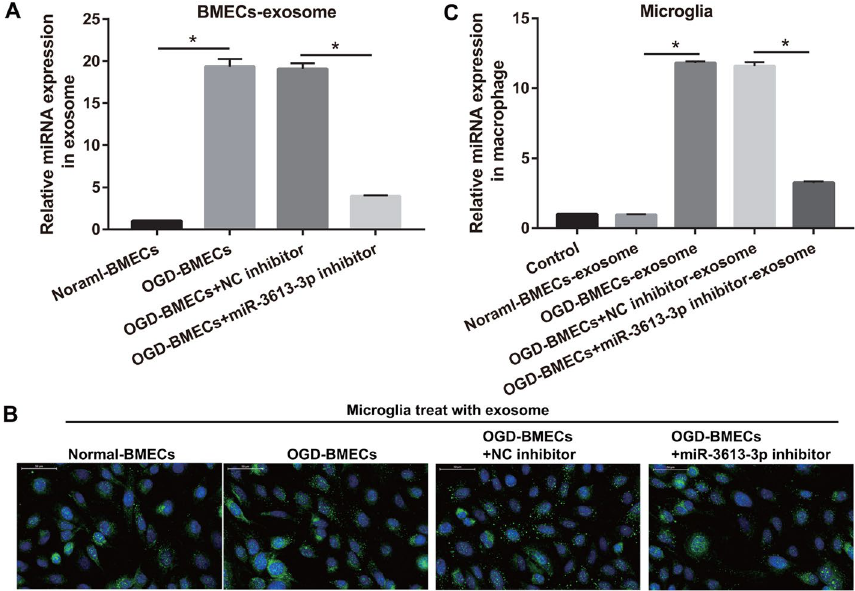
Fig. 2 BMECs secrete miR-3613-3p to transfer into microglia via exosomes. A miR-3613-3p expression in BMEC exosome after transfection was detected by RT-qPCR. B HMC3s were treated with PKH 67 fluorescently labeled BMEC exosome, and the fluorescence was observed under a fluorescence microscope. Green, PKH 67 fluorescence. C miR-3613-3p expression in HMC3 after co-culturing with BMEC exosomes was detected by RT-qPCR. Differences were analyzed using ANOVA, followed by post-hoc Dunnett’s multiple comparisons test. * p <